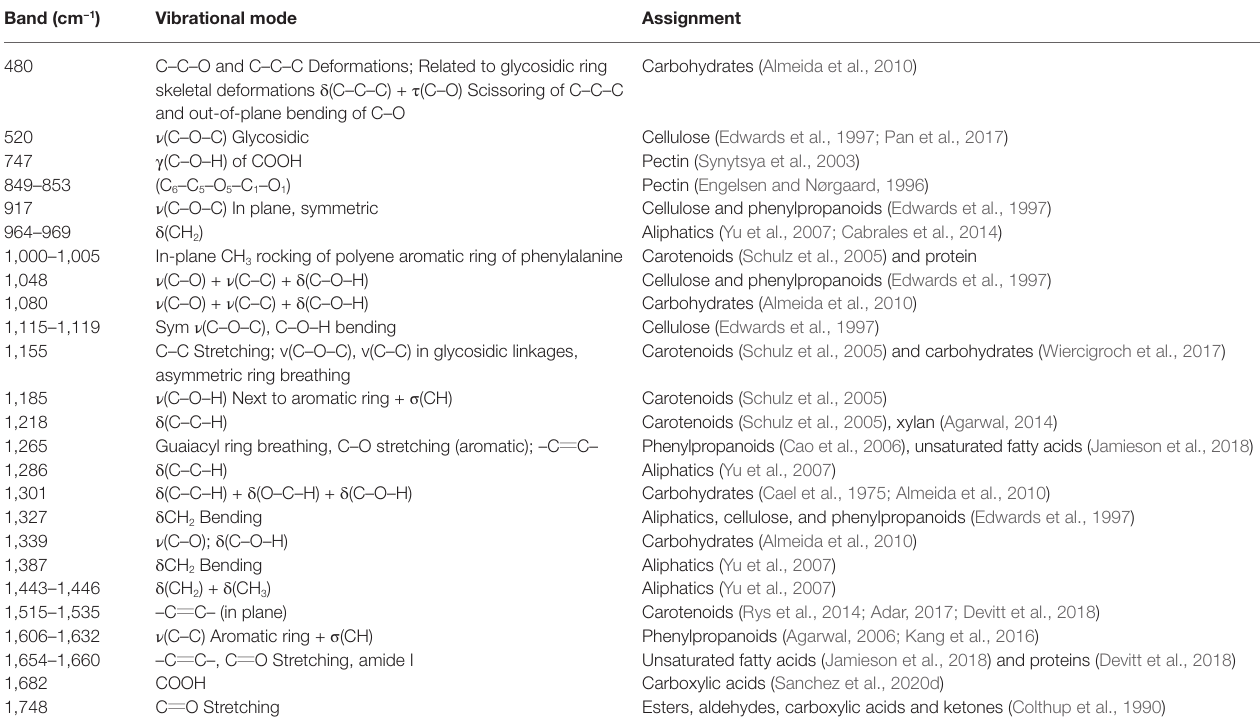
TABLE 1 | Vibrational bands and their assignments for spectra collected from plant leaves and seeds.